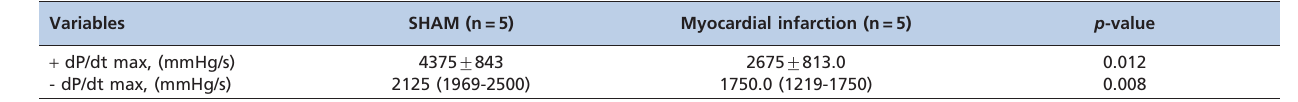
Table 2 - In vitro left ventricular function data.